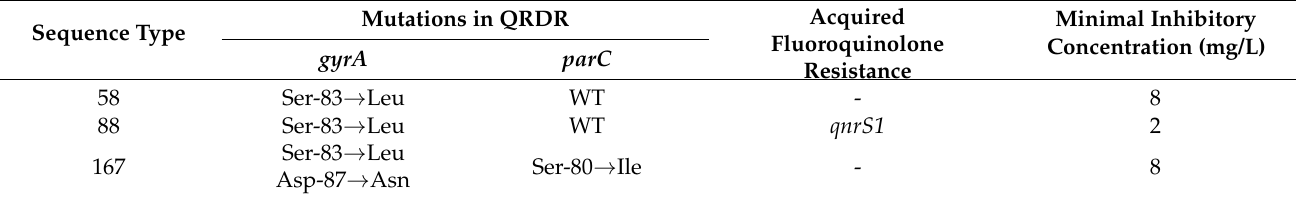
QRDR: quinolone-resistance-determining regions; gyrA and parC: genes encoding for subunits of bacterial gyrase and topoisomerase IV; Ser: serine; Leu: leucine; Asp: aspartic acid; Ile: isoleucine; Asn: asparagine; WT wild type; qnrS1 : quinolone resistance plasmid S1; “ → ” indicates replacement of amino